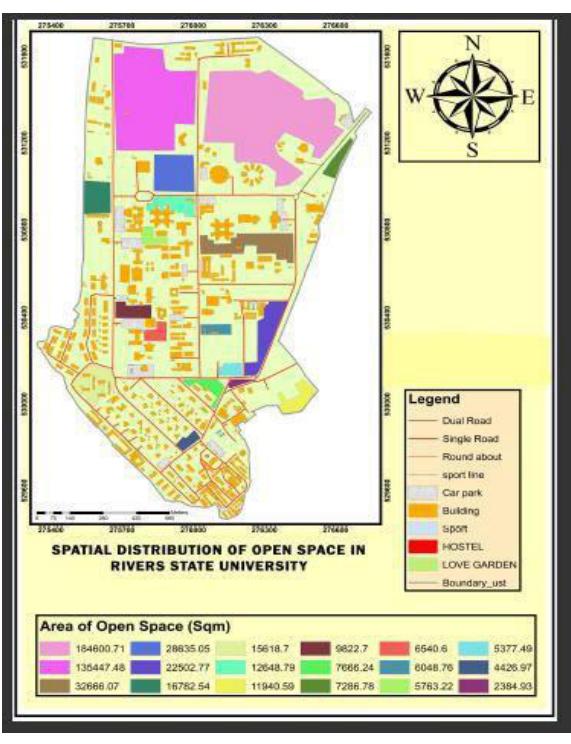
Figure 5: Spatial Distribution of Open Spaces in Rivers state University.